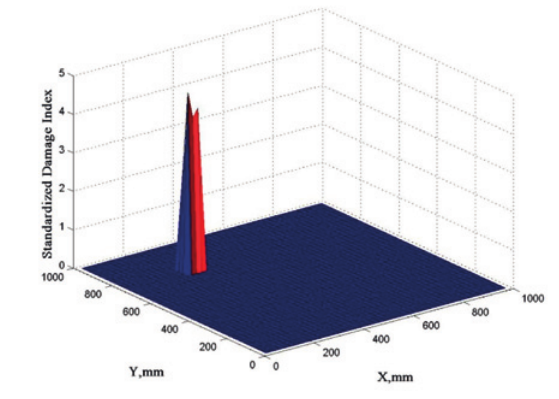
fig. 6. Standardized MSCS damage index for test case 5.2 after truncation